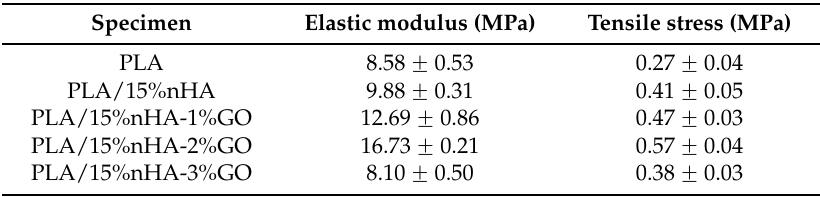
Table 3. Tensile properties of electrospun PLA and PLA-based nanocomposite fibrous mats.